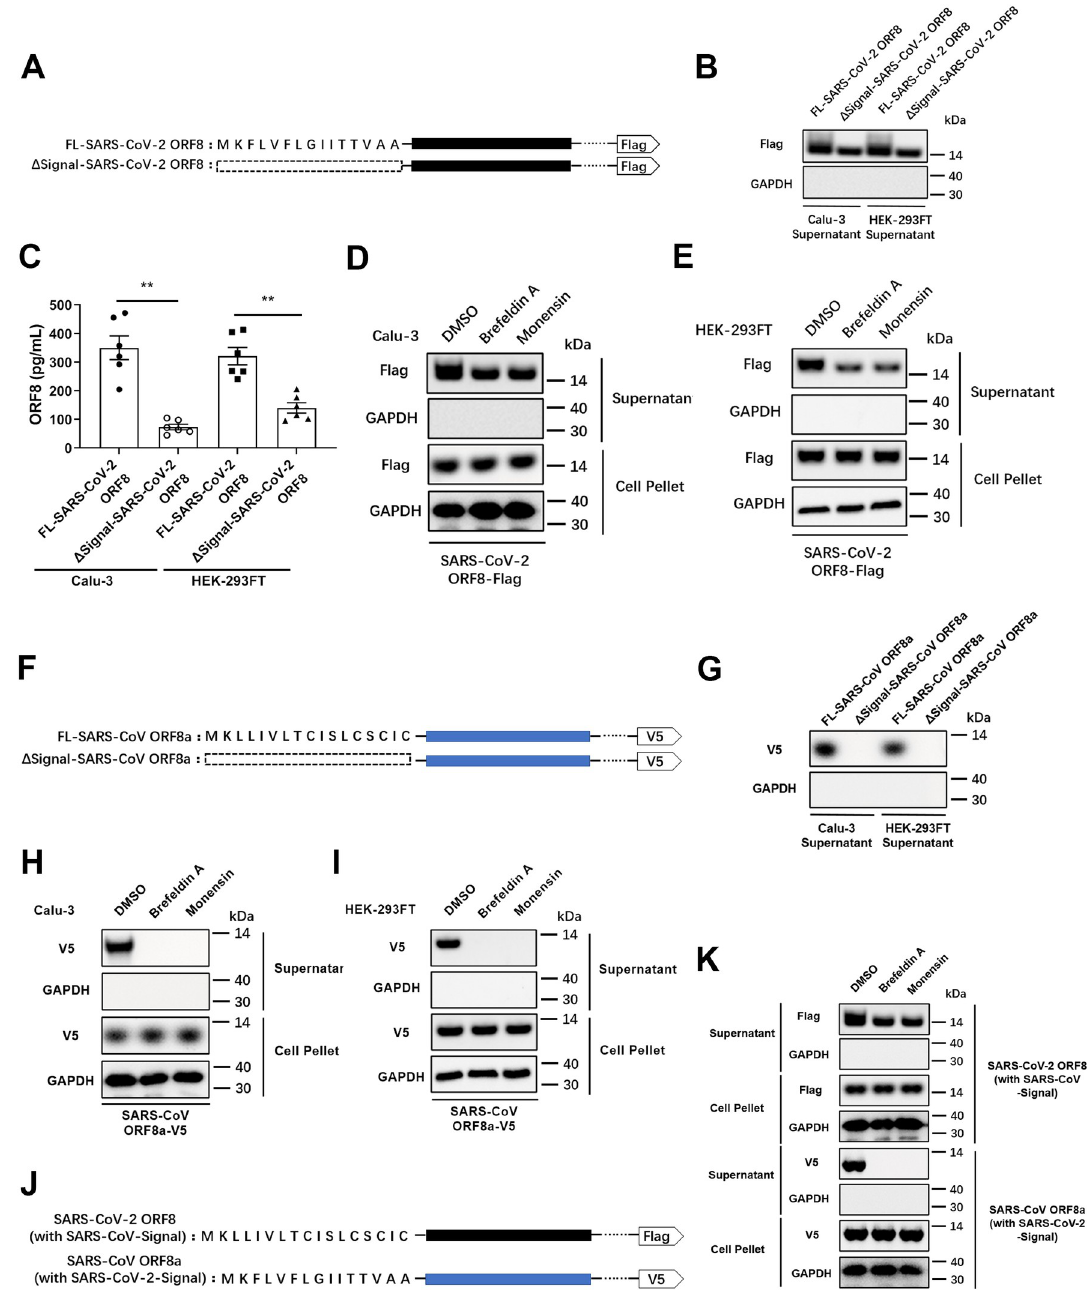
Fig 2. SARS-CoV-2 ORF8, rather than SARS-CoV ORF8, has an unconventional secretion pattern. (A) Structures of SARS-CoV-2 ORF8 and its signal peptide-deleted mutant. (B, C) Full-length SARS-CoV-2 ORF8 or its signal peptide-deleted mutant was transfected into Calu-3 cells or HEK-293FT cells. The secretion of ORF8 was detected by western blotting (B) and ELISA (C). (D, E) Brefeldin A (3 μ g/mL) or Monensin (2 μ M) was used to pretreat Calu-3 cells (D) or HEK-293FT cells (E) for 2 hours. Full-length SARS-CoV-2 ORF8 was transfected into pretreated cells. After 12 hours, the secretion of ORF8 was detected by western blotting. (F) Structures of SARS-CoV ORF8a and its signal peptide-deleted mutant. (G) Full-length SARS-CoV ORF8a or its signal peptide-deleted mutant were transfected into Calu-3 cells or HEK-293FT cells. The secretion of ORF8a was detected by western blotting. (H, I) Brefeldin A or Monensin was used to pretreat Calu-3 cells (H) or HEK-293FT cells (I) for 2 hours. Full-length SARS-CoV ORF8a was transfected into pretreated cells. After 12 hours, the secretion of ORF8a was detected by western blotting. (J) Structures of SARS-CoV-2 ORF8 mutant with signal peptide from SARS-CoV ORF8a (with SARS-Signal), and SARS-CoV ORF8a mutant with signal peptide from SARS-CoV-2 ORF8 (with SARS-CoV-2-Signal). (K) Brefeldin A or Monensin was used to pretreat Calu-3 cells for 2 hours. SARS-CoV-2 ORF8 with SARS-CoV-Signal and SARS-CoV ORF8a with SARS-CoV-2-Signal were transfected into pretreated Calu-3 cells. After 12 hours,